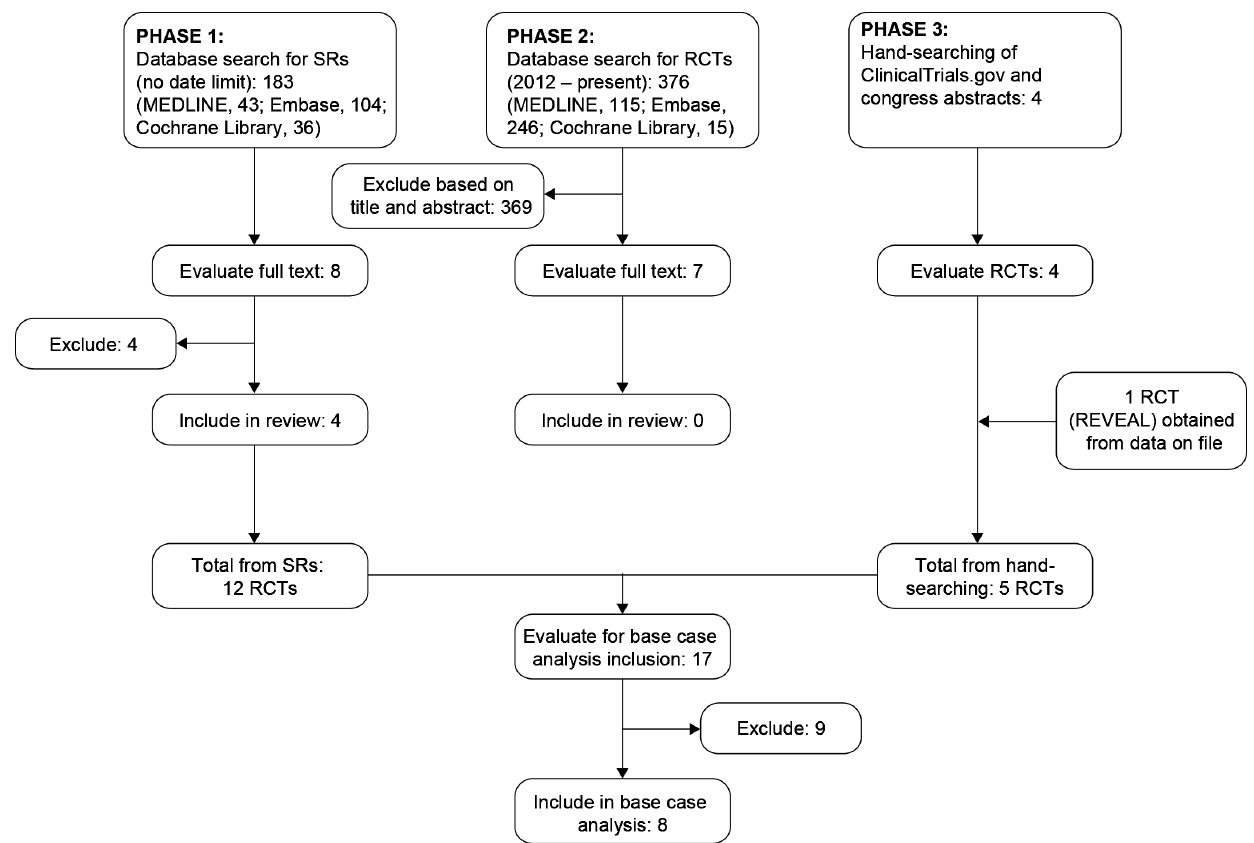
Figure 1. PRISMA diagram of the screening and selection process.